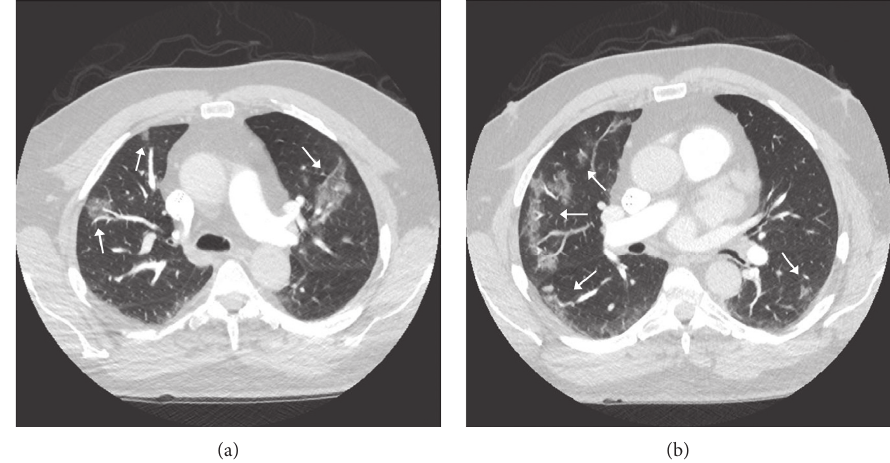
Figure 2: A 67-year-old male with a past medical history of sudden cardiac arrest with the placement of a defibrillator and a recent travel history to Europe presented with nonproductive cough, myalgia, and fever. (a, b) The CTpulmonary arteriogram was performed to rule out pulmonary embolism and demonstrated multiple patchy, peripheral, more organized ground-glass opacities (arrows) compared to the patient in Figure 1. The patient was tested positive for